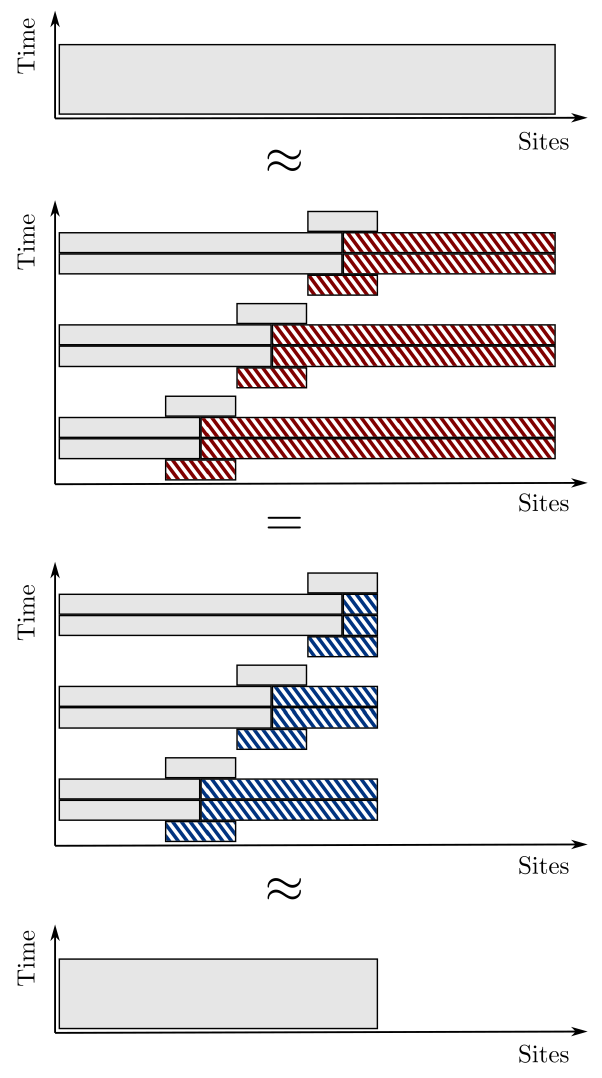
FIG. 2. Construction of the Hamiltonian H within the light lc cone such that e itH Ae − itH ≈ e itH lc Ae − itH lc . Each rectangle repre- sents a unitary supported on the sites covered by the width of the rectangle. Specifically, the rectangle in the top panel represents the evolution e − itH that we want to decompose. We divide the evolution into r steps. Within each step, we truncate the Hamiltonian to H and decompose its evolution using a trunc product formula S . We commute certain matrix exponentials trunc in S (represented by red shaded rectangles) through the trunc observable to cancel their counterpart, obtaining S in the reduce second panel. We reverse this procedure within the light cone to construct S in the third panel, which approximates e − itH lc as lc illustrated in the bottom